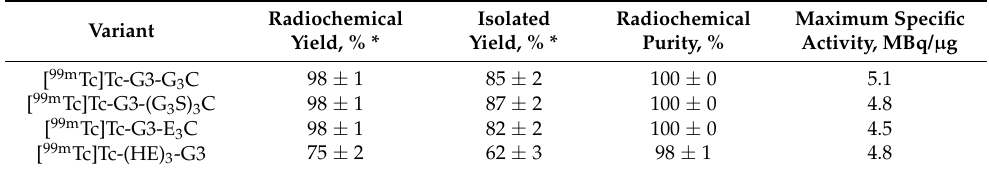
Table 2. Radiochemical yield, isolated yield, radiochemical purity, and maximum specific activity of 99m Tc-labeled G3 variants. Experiments were performed in duplicates. * Radiochemical yield is based on iTLC analysis of the labeled constructs before purification. Isolated yield is defined as the percentage of activity in the reaction vial before purification, which was recovered in the high molecular weight fraction after purification.